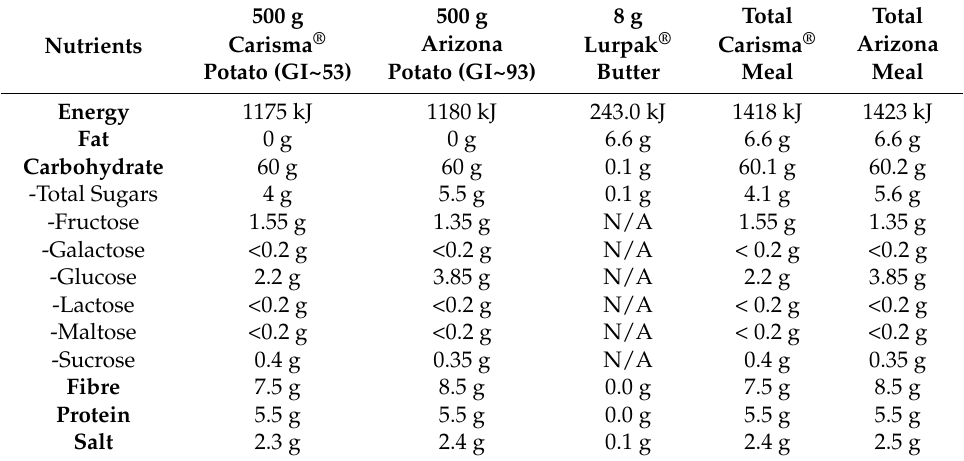
Table 1. Composition of the potato meals.